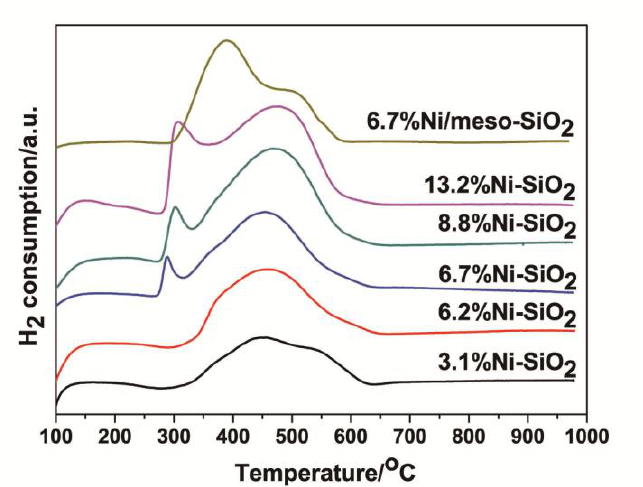
-TPR profiles of the Ni/meso-SiO 2